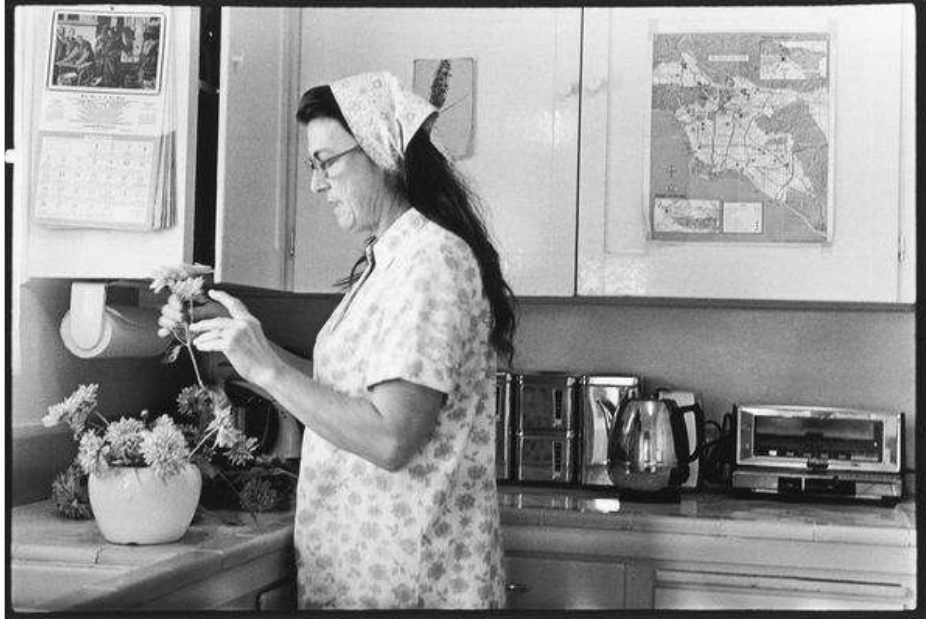
Figure 8: Allan Sekula, Aerospace Folktales (1973)